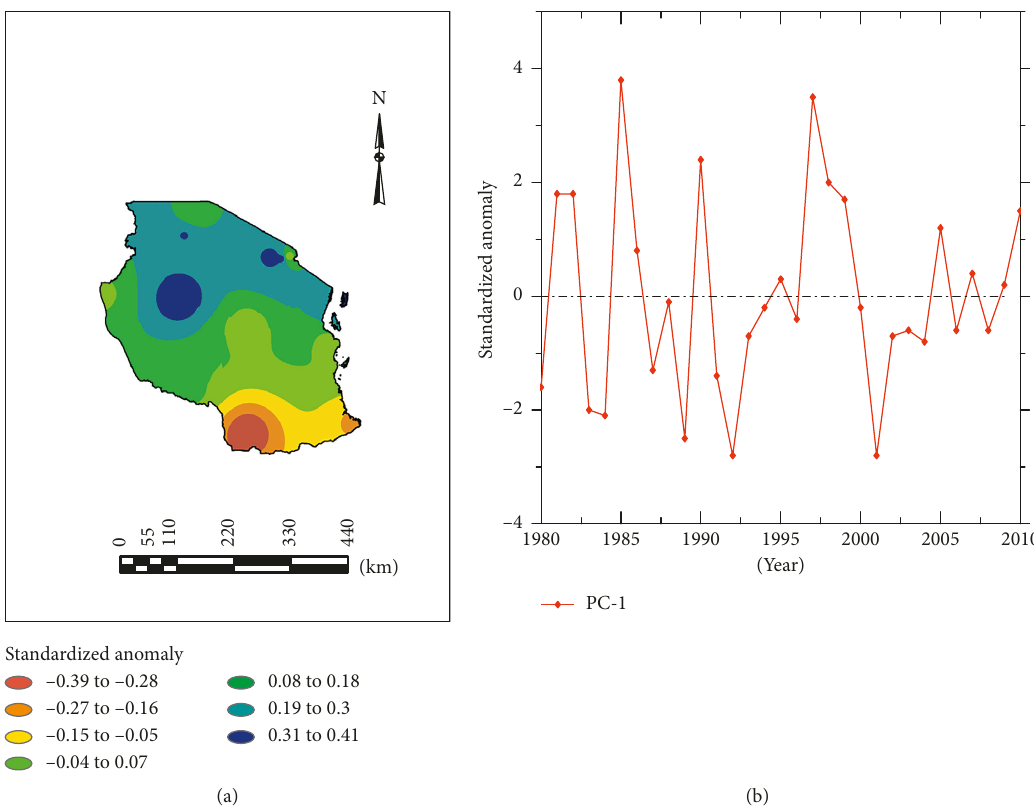
Figure 4: (a) The spatial pattern of the first EOF mode (EOF-1) and its corresponding PC time series (b) of the mean heavy rainfall during the MAM season based on 1980–2010